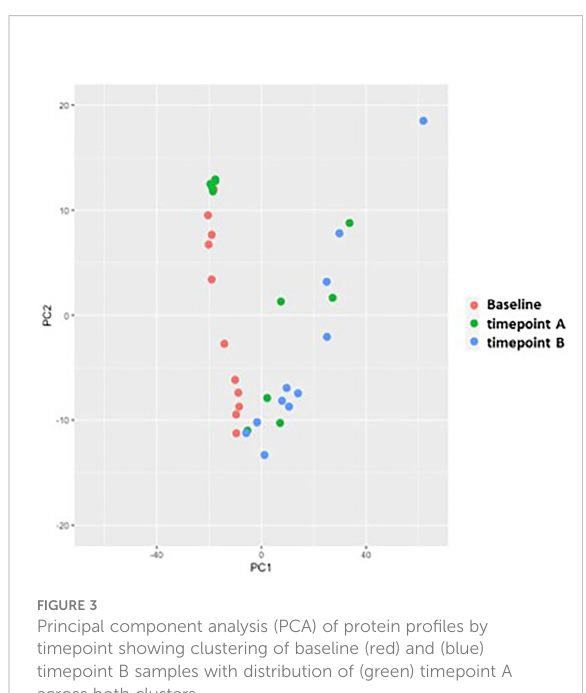
FIGURE 3 Principal component analysis (PCA) of protein pro fi les by timepoint showing clustering of baseline (red) and (blue) timepoint B samples with distribution of (green) timepoint A across both clusters.